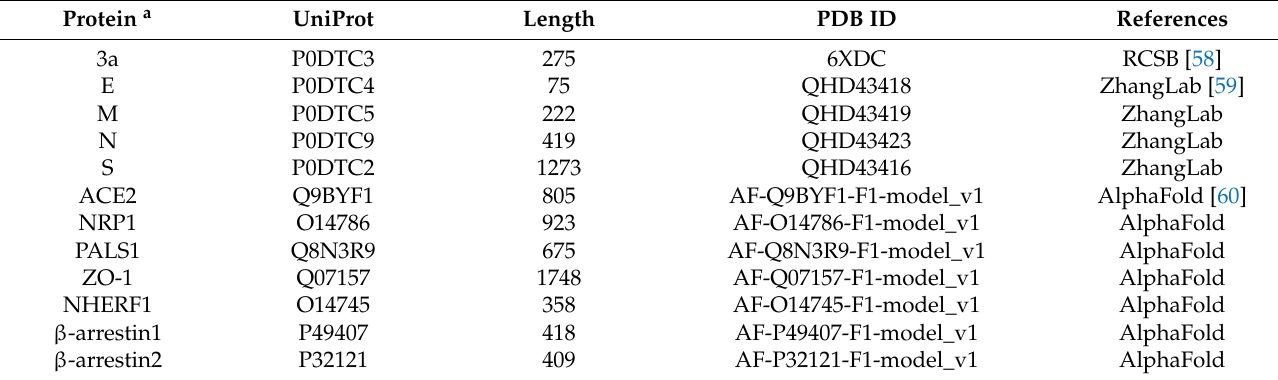
Table 2. PDB structures considered in this